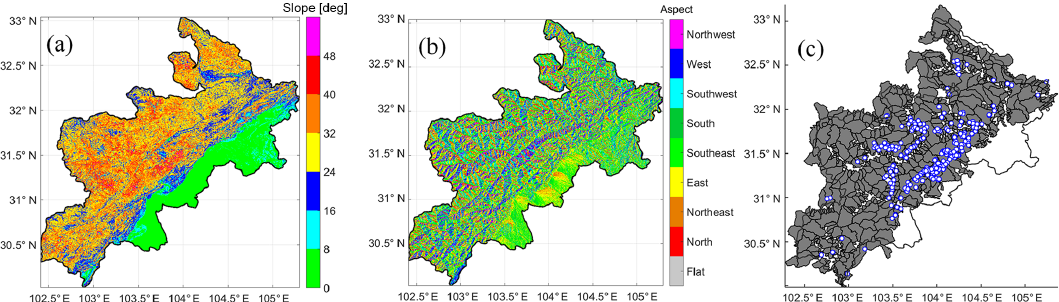
Figure 3. Morphology and potential debris flow watersheds map over study area: (a) slope; (b) aspect; (c) potential debris flow watersheds (gray polygon) with debris flow observation (blue circle).